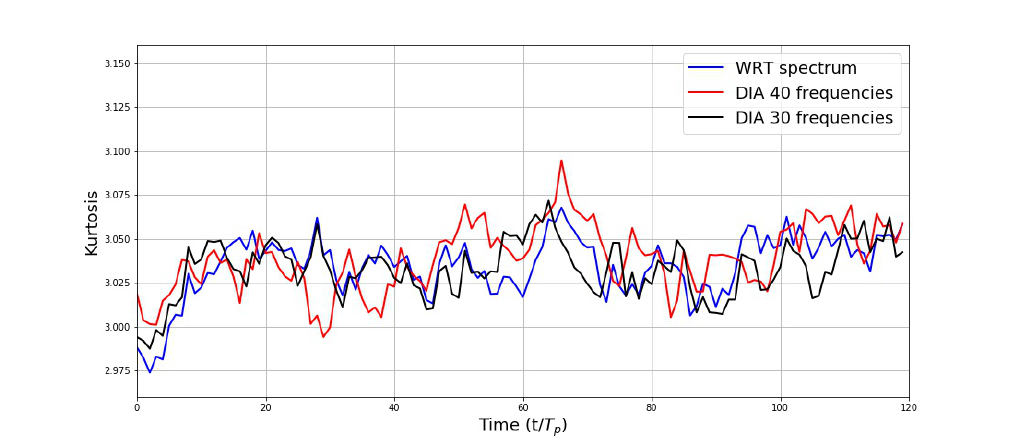
Figure 4. Time evolution of kurtosis for the Draupner sea state, for three different wave spectra and the use of the strong energy filter. Time is normalized by the peak wave period T p of the spectrum. The statistical parameters are estimated from an ensemble of 20 HOS simulations. The initial artificial transients are excluded from the ensemble averages as they are the result of a ramping function applied to the HOS equations to smoothly activate